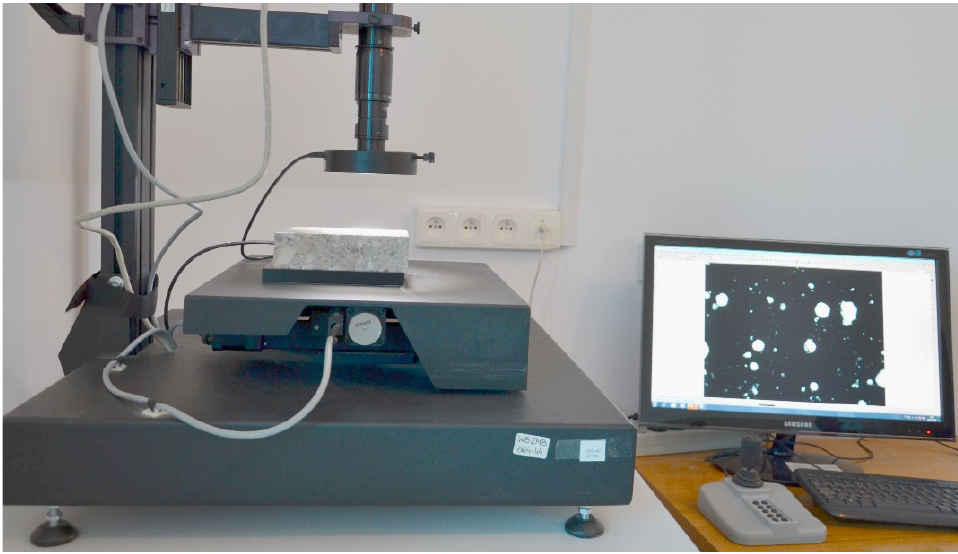
Figure 3. Lab set-up for testing the porosity structure of the hardened concrete.